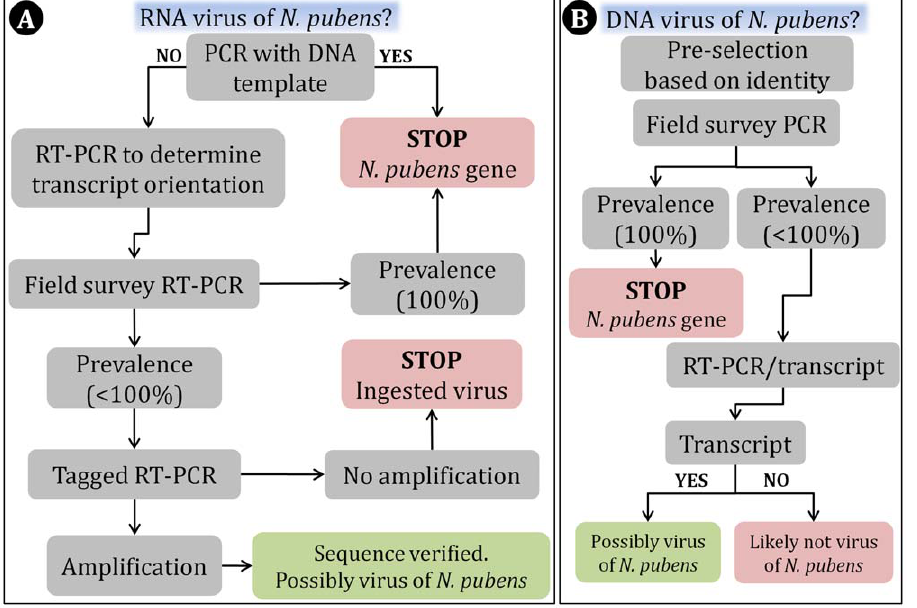
Figure 1. Stepwise decision tree employed as a guide to assess the likelihood that a given sequence was of RNA (A) or DNA (B) viral origin. doi:10.1371/journal.pone.0031828.g001 (Table 1). PCR was conducted with RNase-treated DNA extracted from the same N. pubens colonies used in expression library creation. If PCR yielded an amplicon, it was concluded that the sequence was likely an N. pubens gene and experiments concerned